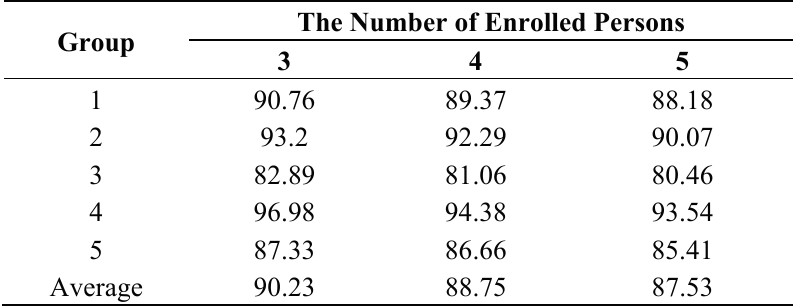
Table 5. GARs based on the number of enrolled persons (unit: